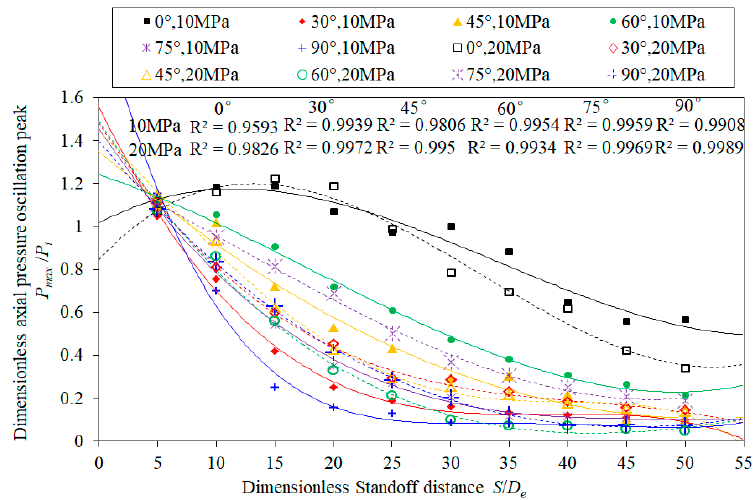
Figure 7. The dimensionless P max against dimensionless S .